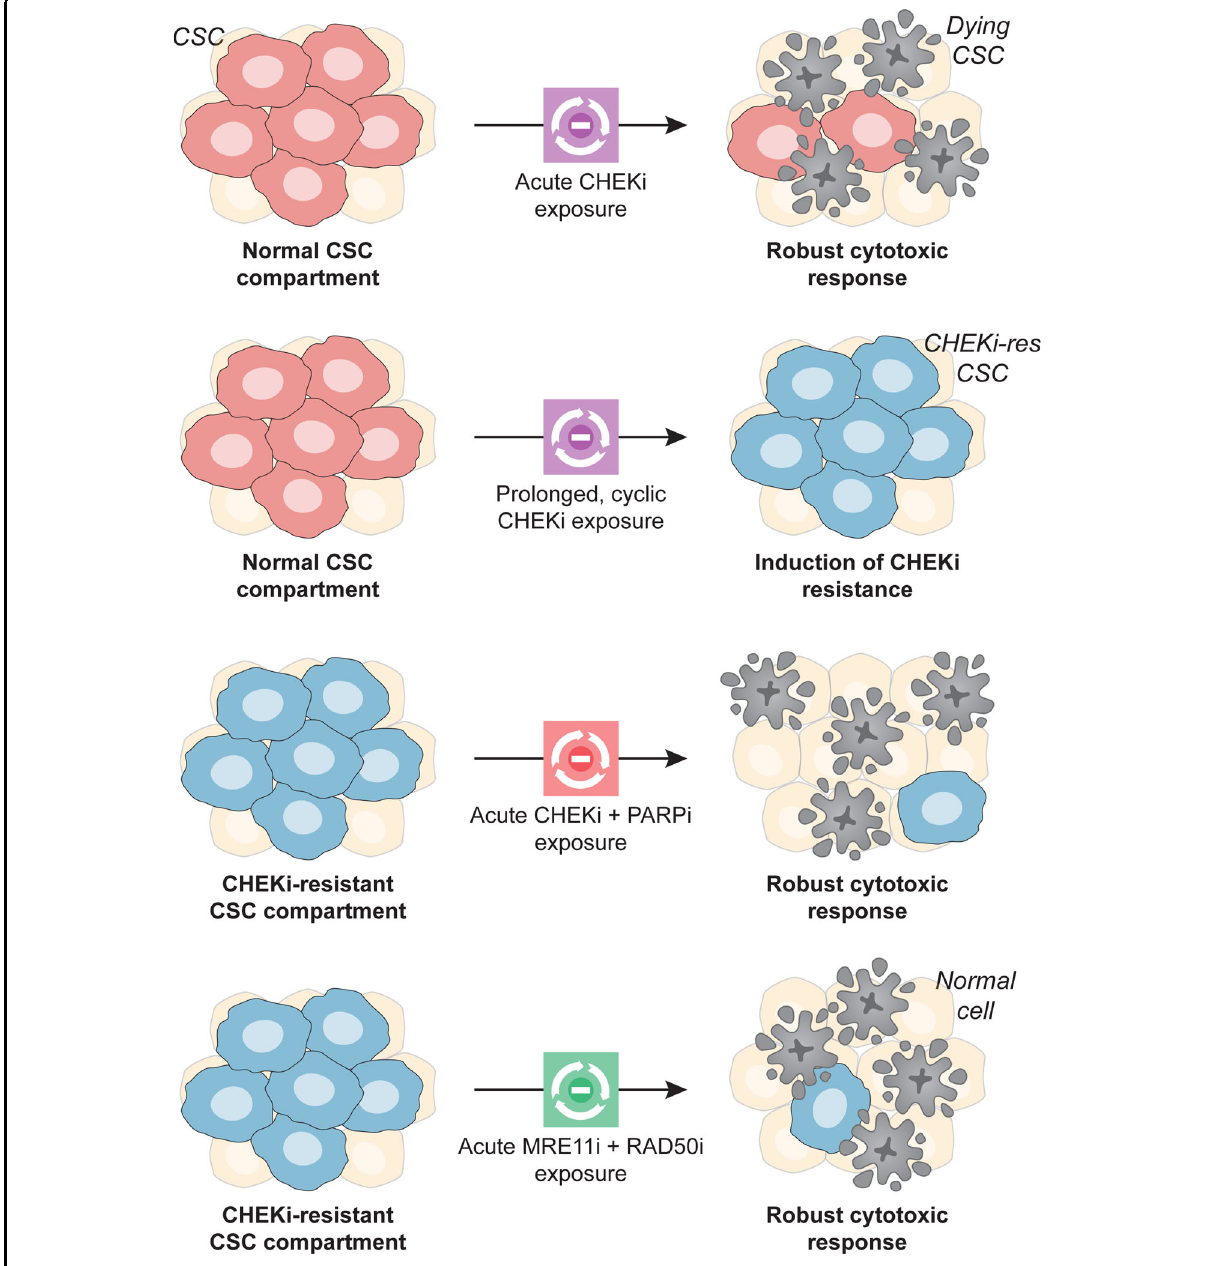
Fig. 1 Targeting the DNA-damage response to tackle the CSC compartment. Cancer stem cells (CSCs) are generally resistant to DNA-damaging agents, at least in part owing to a hyper pro fi cient DNA-damage response, but often rely on checkpoint kinase 1 (CHEK1, best known as CHK1), a major signal transducer in the DNA replication stress response, for survival. Conversely, CSCs with innate (not shown) or acquired resistance to CHK1 inhibitors (CHK1is) exhibit poly(ADP-ribose) polymerase 1 (PARP1) upregulation and require the combined functions of CHK1 plus PARP1, and MRE11 homolog, double-strand break repair nuclease (MRE11) plus RAD51 recombinase (RAD51) for survival. Thus, CHK1 plus PARP1 and MRE11 plus RAD51 identify two main hubs for combinatorial therapeutic approaches against CSCs based on the principle of synthetic lethality. MRE11i MRE11 inhibitor, PARP1i PARP1 inhibitor, RAD51i RAD51